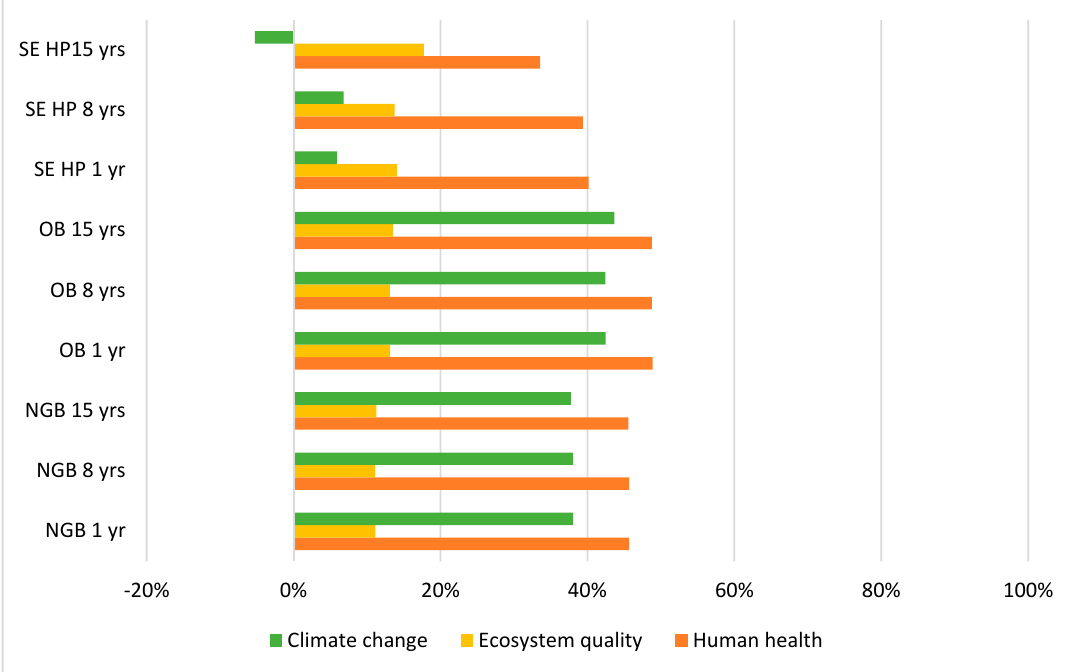
Figure 7. Comparison of damage assessment and characterization Stirling cycle ‐ based HP (SE HP), oil boiler (OB), and natural gas ‐ fired boiler (NGB) on a relative scale.